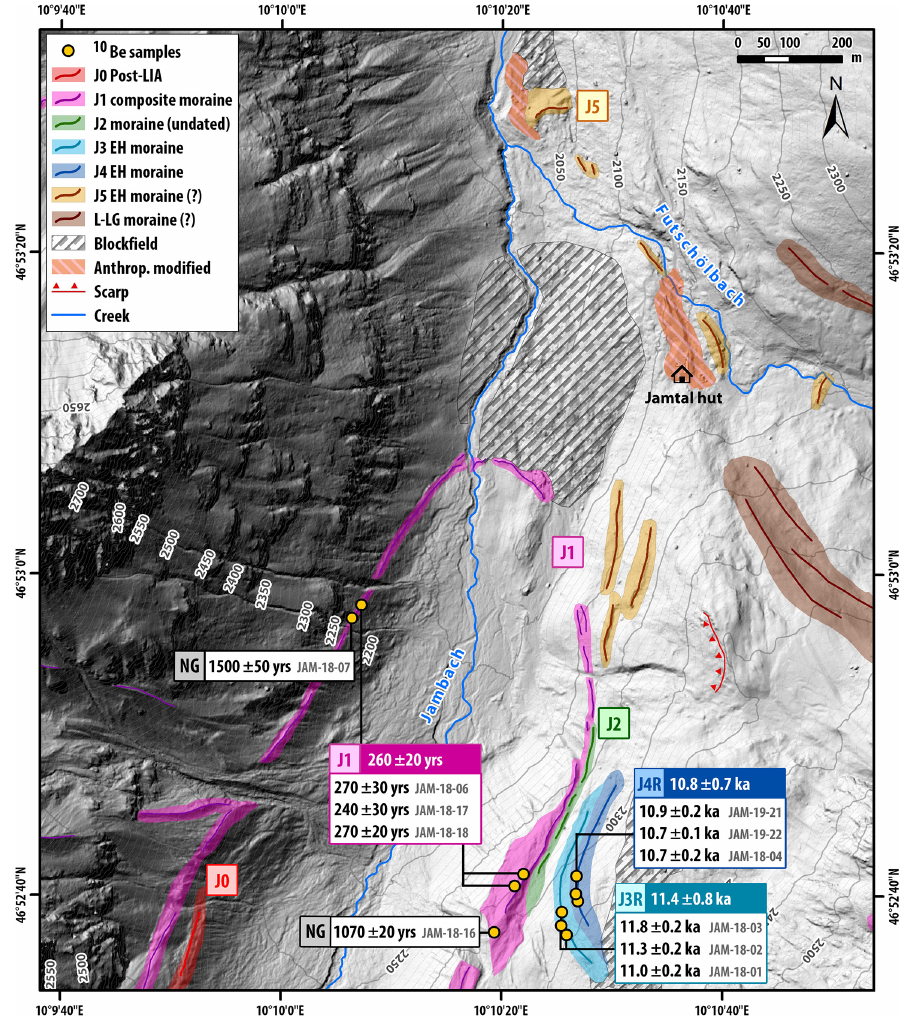
Figure 2. Holocene moraine chronology of Jamtal. J0 (red) has been deposited after the LIA but prior to the 20th century (Fischer et al., 2019; K. u. k. Militärgeographisches Institut, 1870–1887). J1, J3R, and J4R were dated in this study. Ages along the J1 moraine (pink) indicate that Jamtalferner reached its historical maximum during the second half of the 18th century and during the Neoglacial (NG). Earlier phases of glacier stabilization that exceeded subsequent Holocene culminations are evidenced by moraines J3R and J4R, which both date to the EH. DEM provided by © Land Tirol (resolution